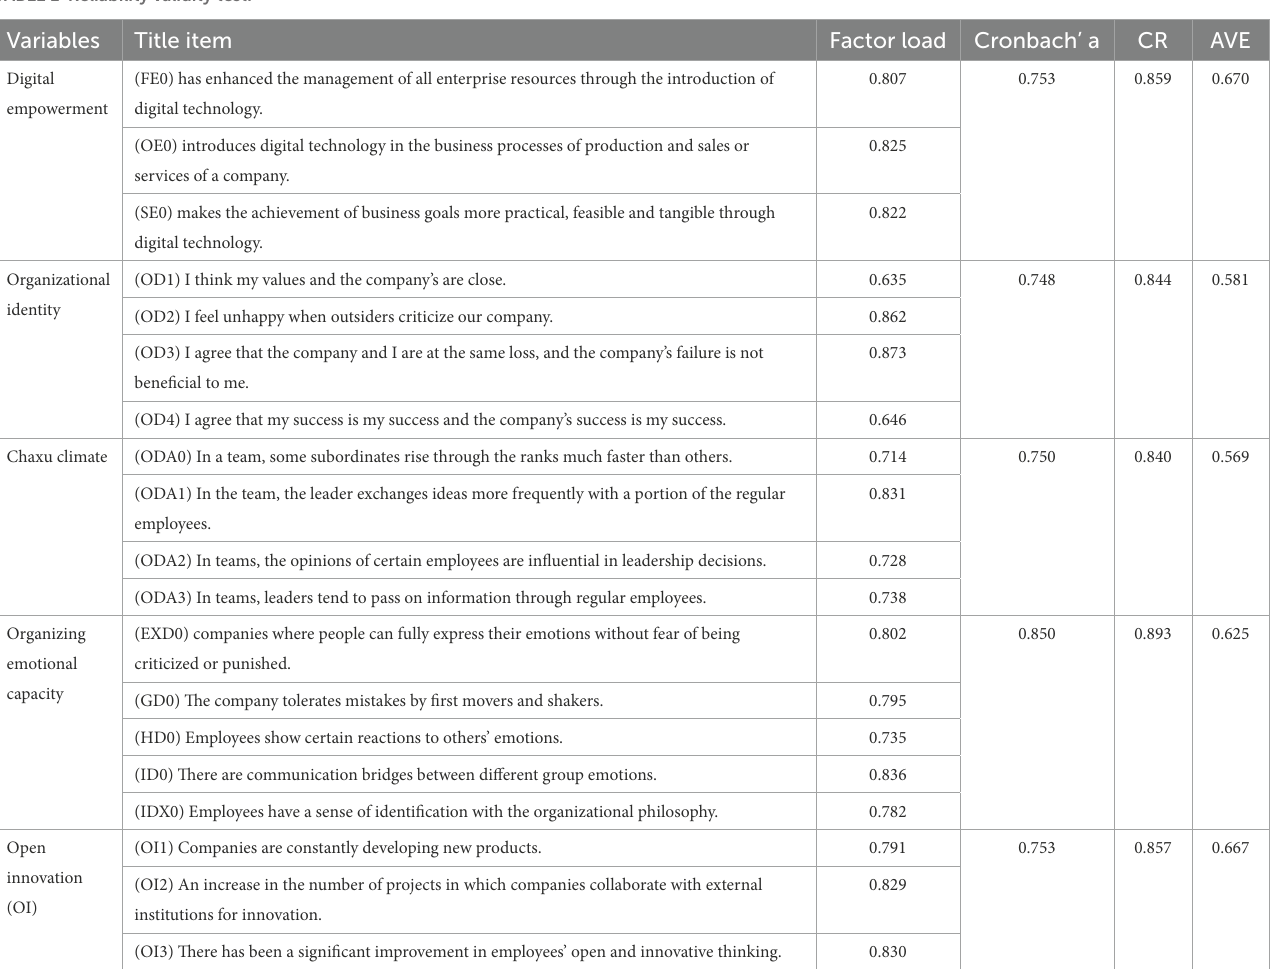
TABLE 1 Reliability validity